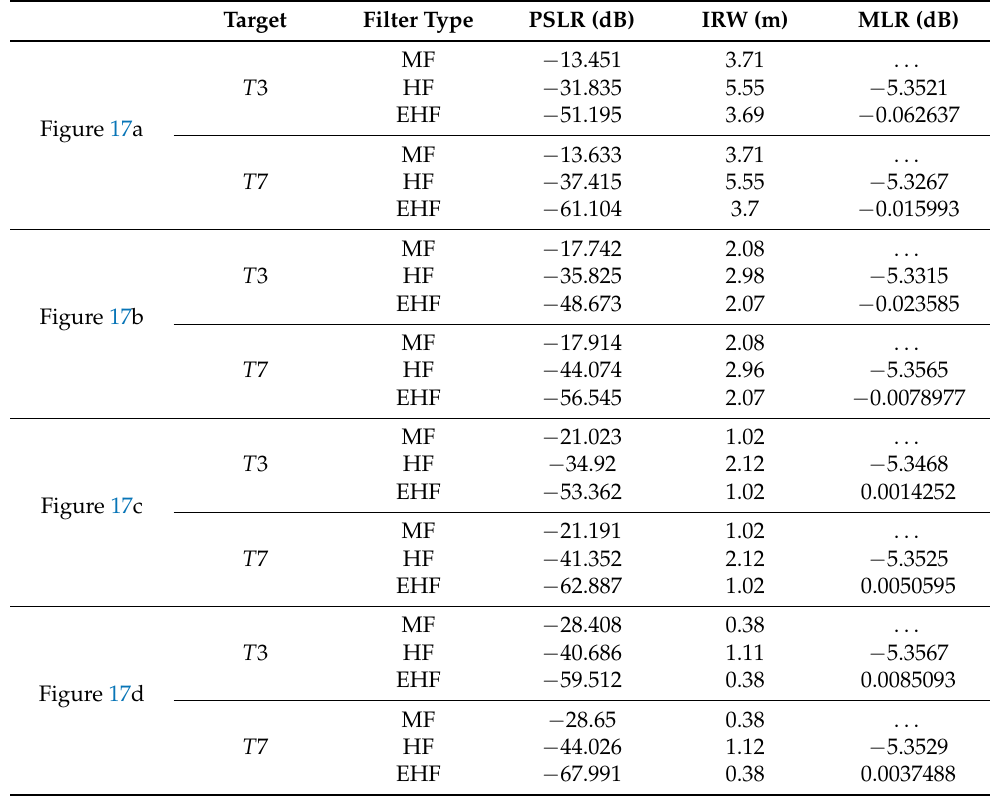
Table 4. Measurements of PSLR, IRW, and MLR, of T 3 and T 7, for MF HF, and EMF, as shown in Figure